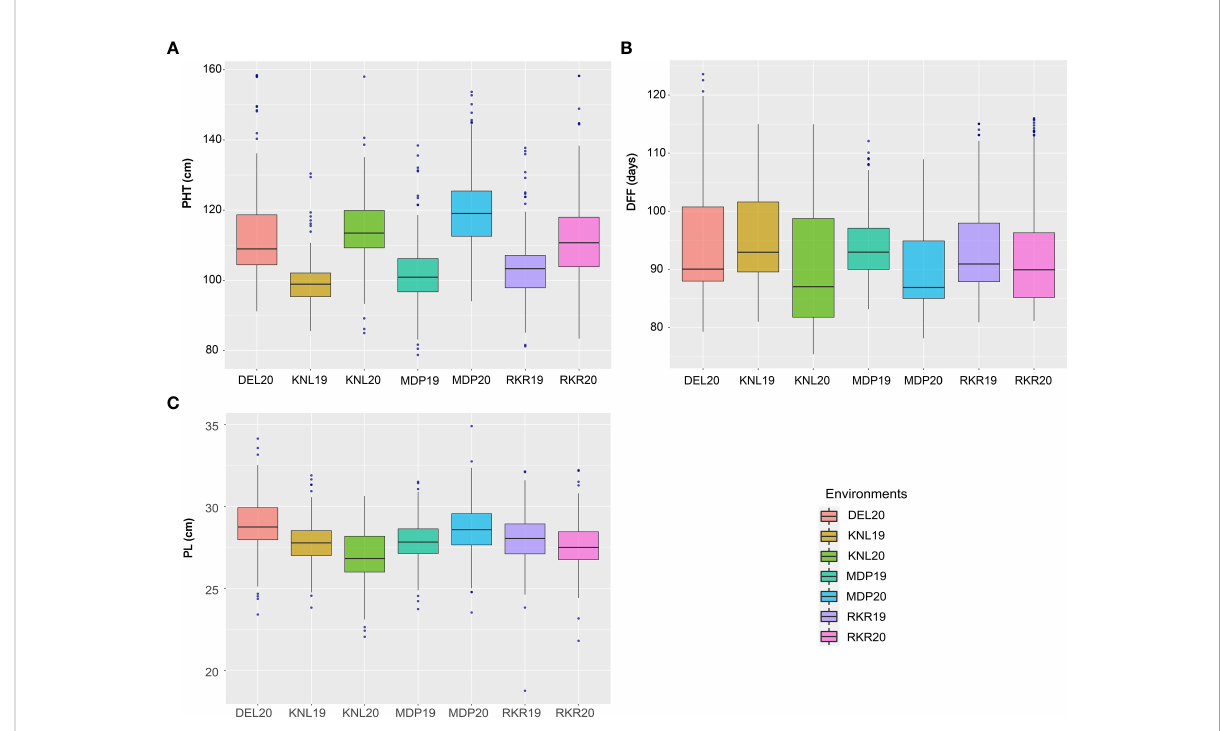
FIGURE 1 Boxplots depicting the distribution of (A) Plant height (cm), (B) Days to fi fty per cent fl owering and (C) Panicle length (cm) across seven